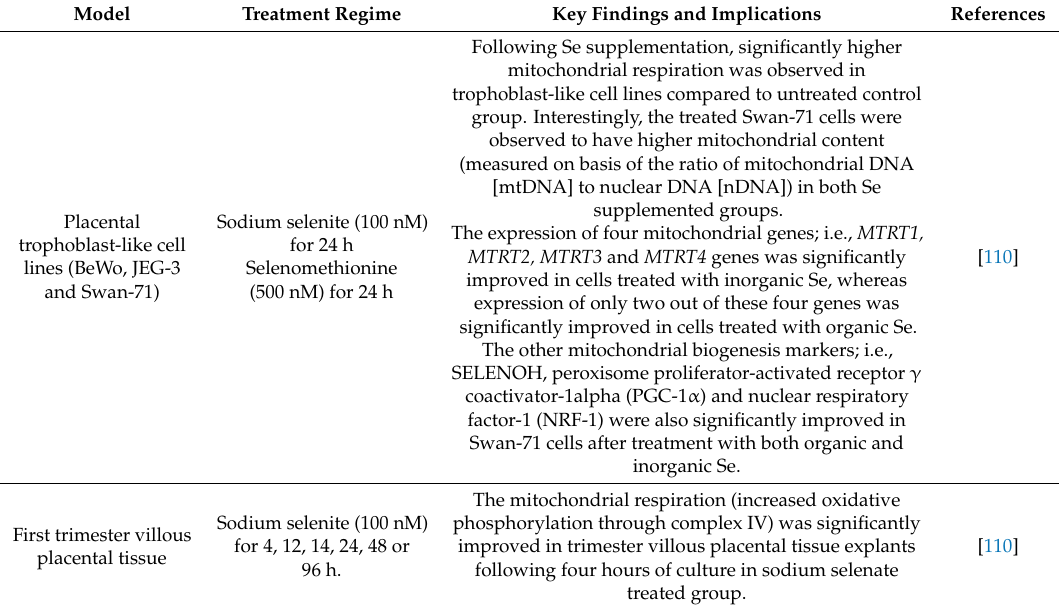
Main characteristics and results of recent studies assessing the effect of selenium supplementation on mitochondrial function and expression of mitochondrial biogenesis markers in placental trophoblast cell